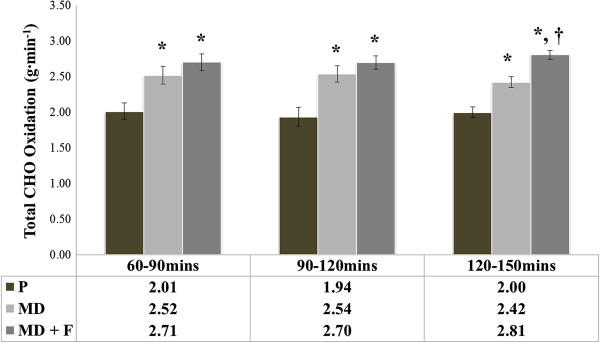
Assessment of test beverages on mean CHOTOT oxidation rates at various timepoints during the submaximal exercise trial. Figure 2 shows the difference between test beverages for total carbohydrate oxidation rates at specific 30 minute time periods in the final 90 minutes of the oxidation trial. Data are presented as mean ± SE; n = 14. P, Placebo; MD, maltodextrin beverage; MD + F, maltodextrin-fructose beverage; CHOTOT, total carbohydrate oxidation rates. *denotes significant difference (P < 0.005) to P within timepoint assessment. † denotes significant difference between MD and MD + F within timepoint assessment (P = 0.004).